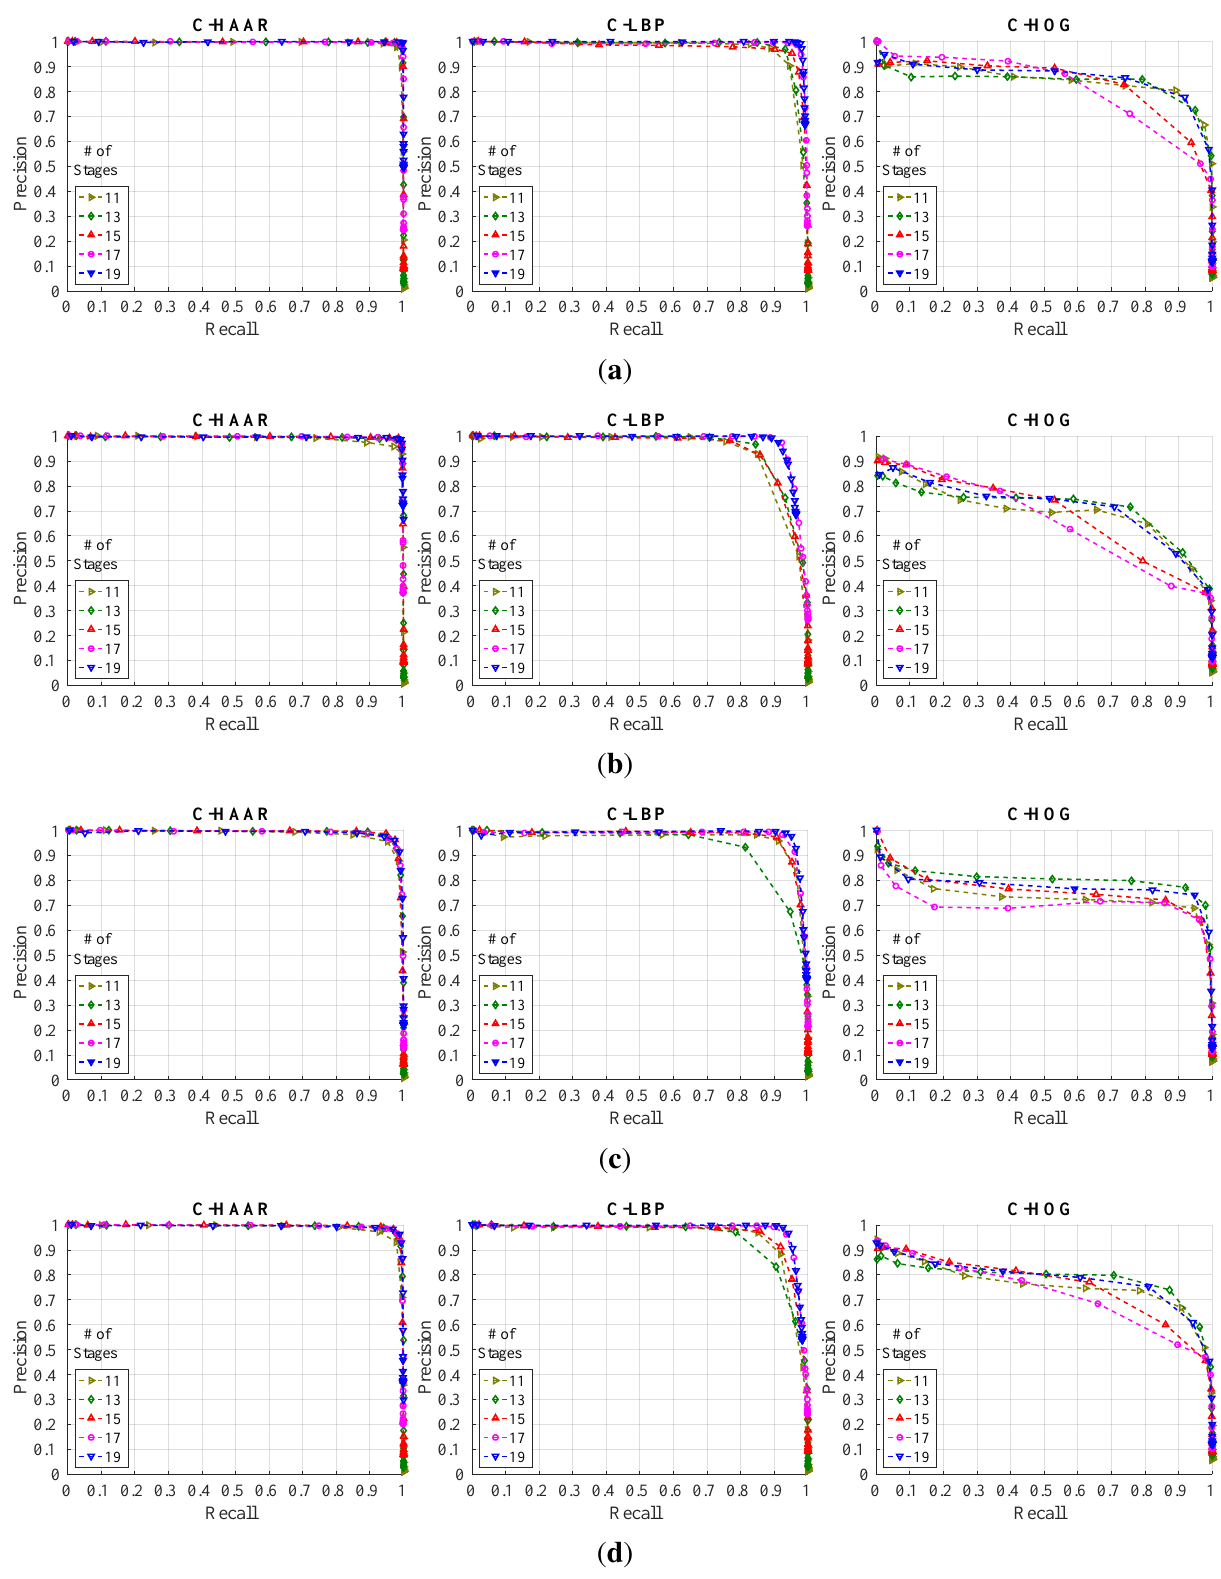
Figure 13. PR curves for outdoor evaluation (best viewed in color). ( a ) Performances for calm test video; ( b ) performances for agile test video; ( c ) performances for moving background test video; ( d ) overall